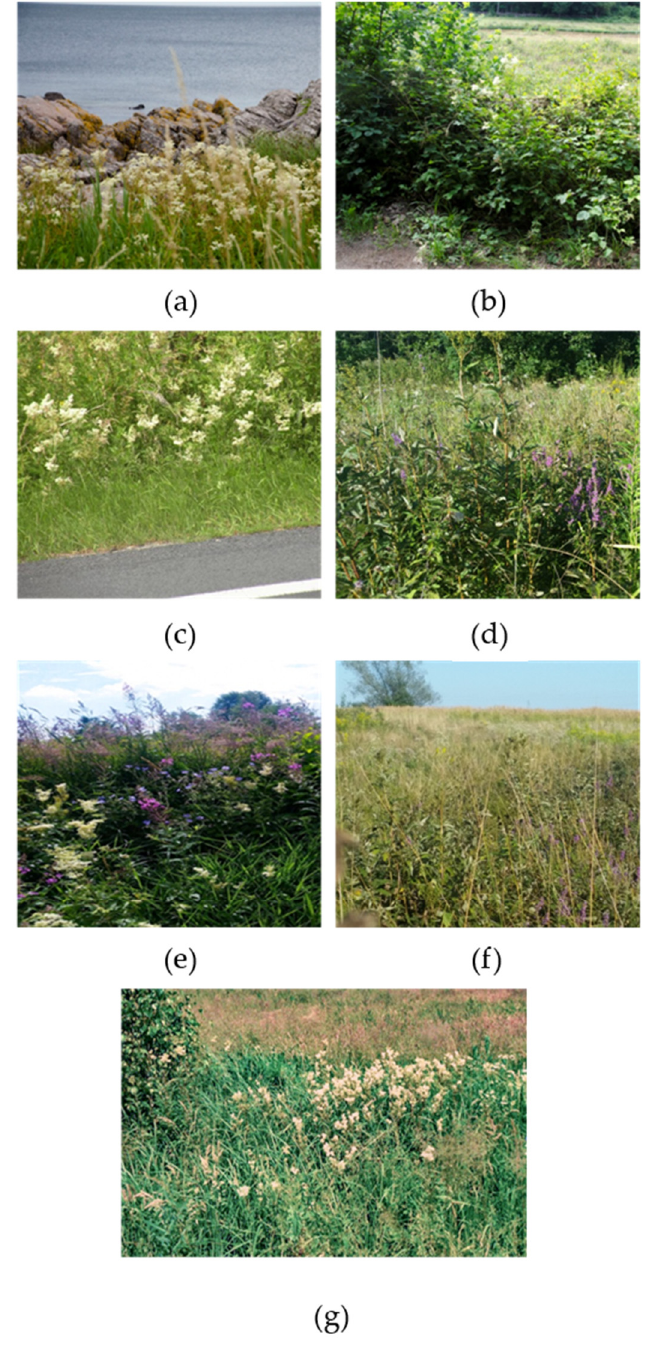
Figure 6. Individual locations of the meadowsweet: Alinge-Sandvig ( a ), Klemensker ( b ), Nexo ( c ), Iskrzynia ( d ), Haczów ( e ), Baligród ( f ), Jab ł onka ( g ). Iskrzynia ( d ), Hacz ó w ( e ), Baligr ó d ( f ), Jabłonka ( g